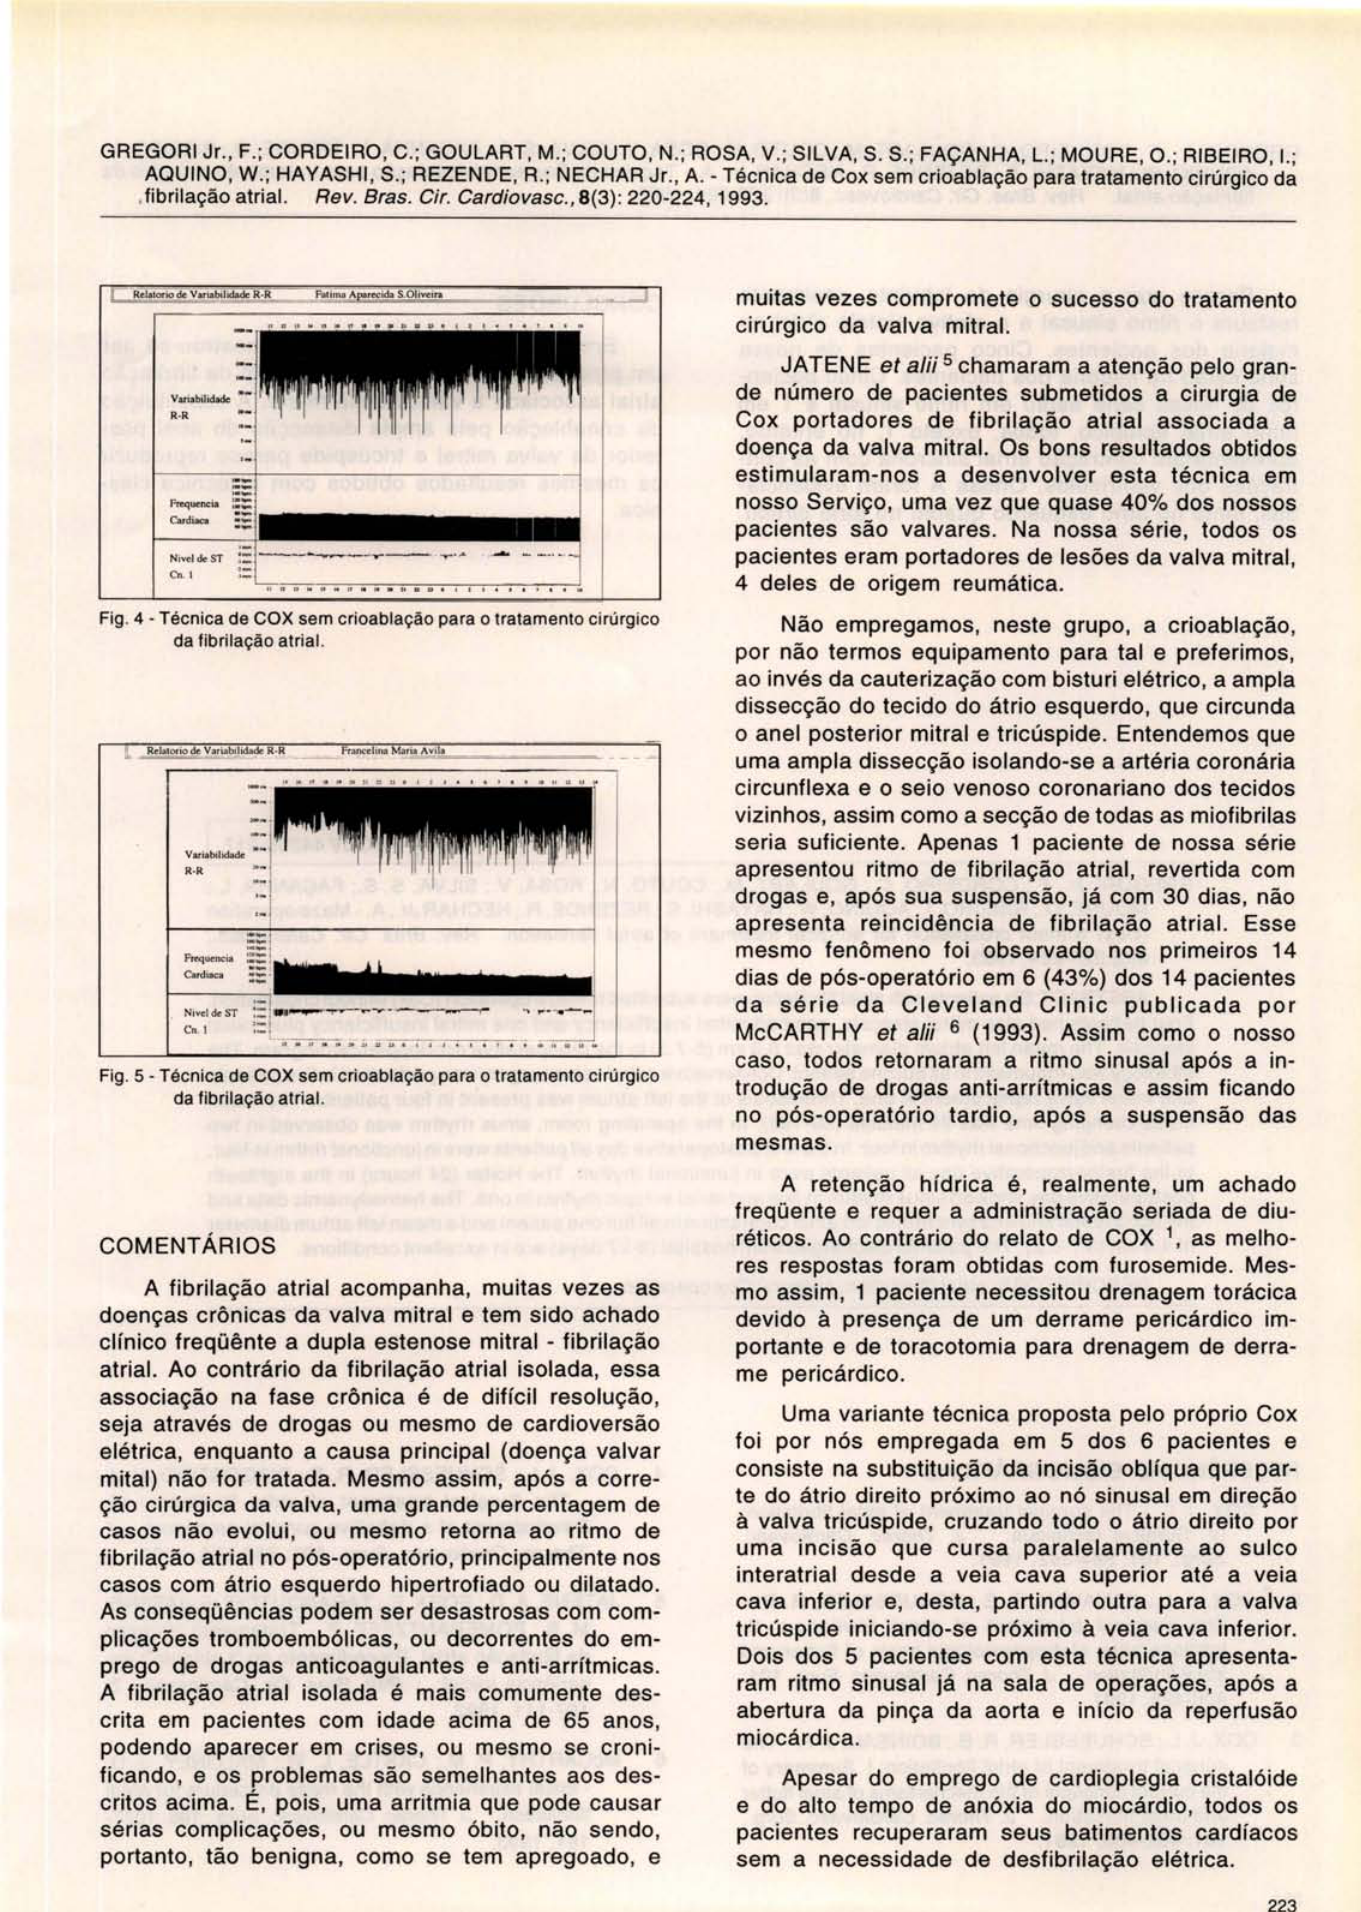
Fig. 5 - Técnica de COX sem crioablação para o tratamento cirúrgico da fibrilação atrial.